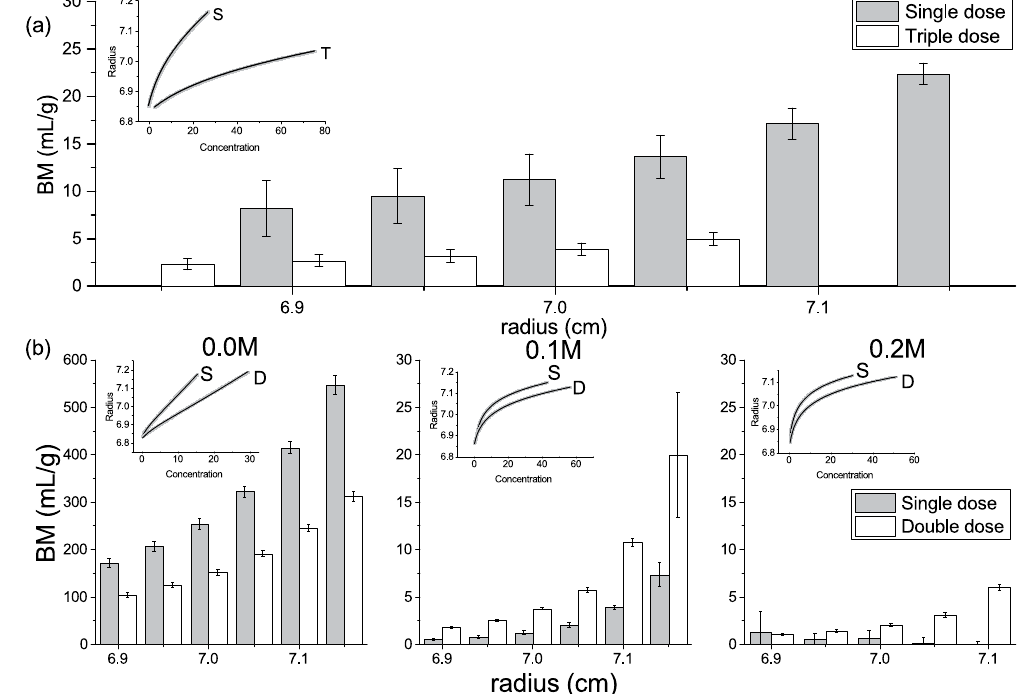
Figure 3. BM estimated by the INVEQ algorithm of insulin preparations. ( a ) glargine AUC-SE profile measured at 25 000 rpm (inset, S = single dose, T = triple dose), with the second virial coefficient factor BM fitted at different radial positions for single (grey) and triple (white) dose. ( b – d ) Degludec measured at 15 000 rpm (insets, S = single dose, D = double dose), with ( b ) unmodified ‘0.0 M’ ionic strength, ( c ) 0.1 M ionic strength; and ( d ) 0.2 M ionic strength. BM was fitted at different radial positions for single (grey) and double (white) dose. Standard error of regression indicated with error bars which represents how closely the fit matches the raw data. Note the 30x difference between the BM scales of ( b ) and ( c , d